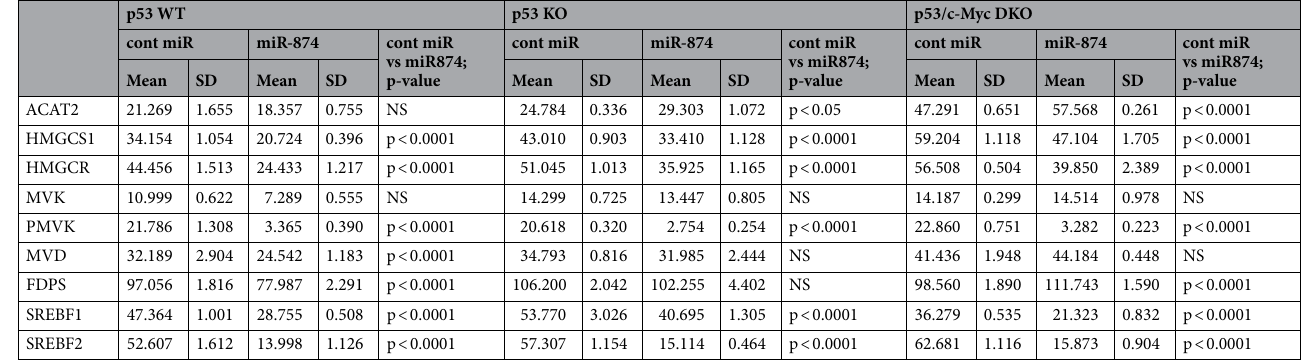
Table 1. Mevalonate pathway and SREBF expression determined by RNA-seq